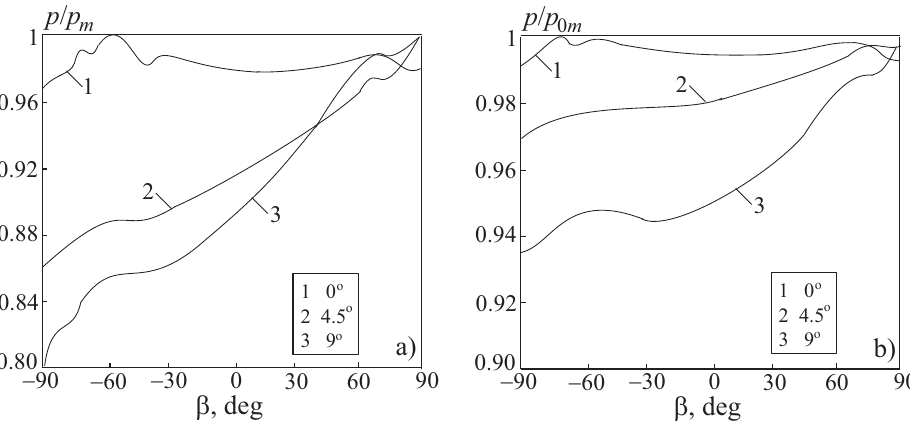
Figure 8. Distributions of static pressure ( a ) and total pressure ( b ) along stagnation line for various angles of nozzle rotations for cylindrical